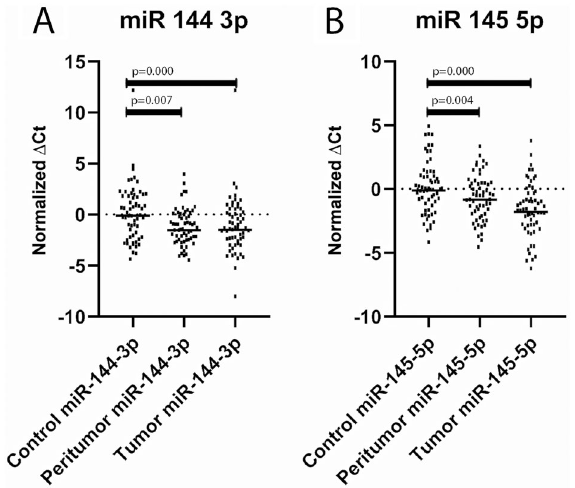
Figure 3. Statistically significant differences in the expression levels of miR-144-3p and miR 145-5p between tumor tissue, peritumor mucosa and healthy control laryngeal mucosa. Pairwise comparison using the Friedman test (with Bonferroni correction); miR-144-3p [mean rank]: 1.58 versus 2.14 versus 2.29, p = 0.000; miR-145-5p [mean rank]: 1.57 versus 2.15 versus 2.28, p =